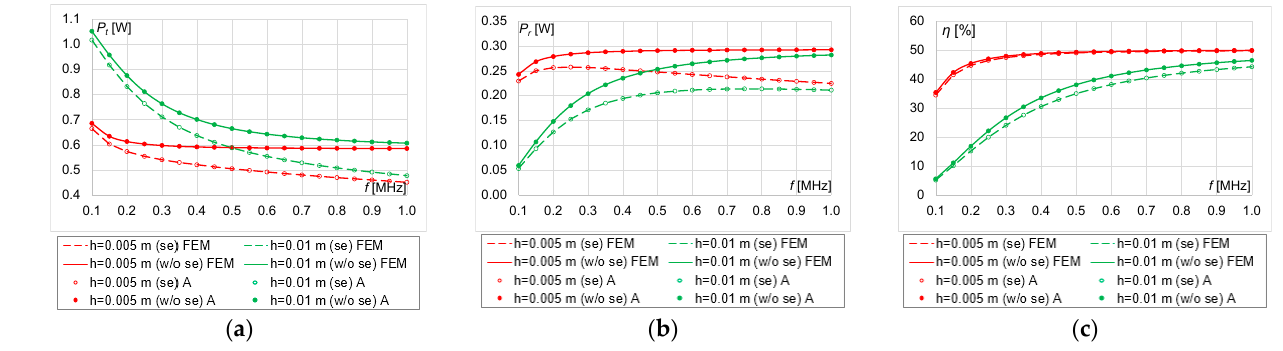
Figure 19. Results for n = 30 for the cases with and without skin effect: ( a ) P t , ( b ) P r , ( c ) η .